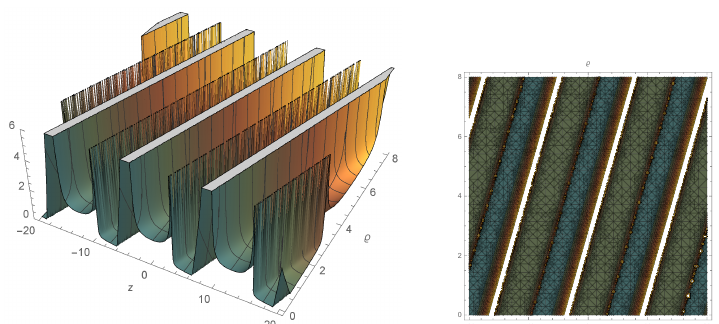
Figure 1. Three-dimensional (3D) and contour plots of the singular periodic wave solution of Equation (17).